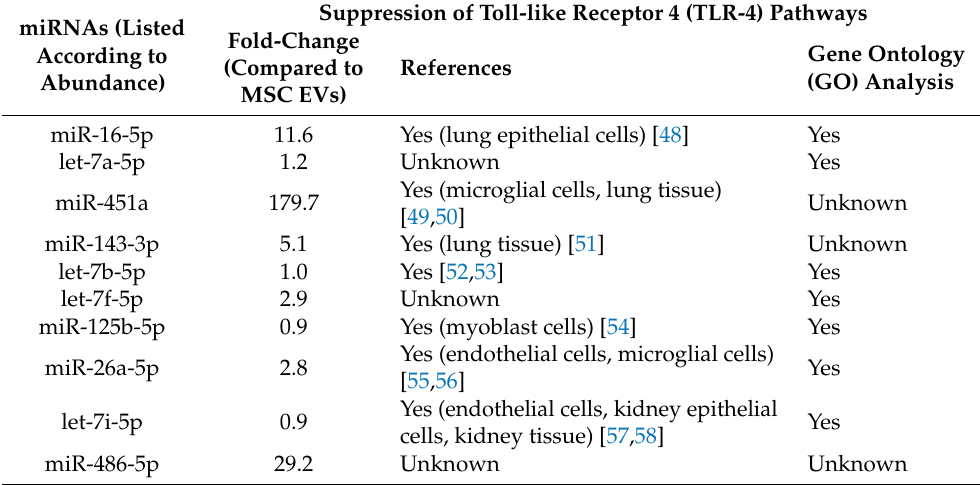
Table 2. Ten most abundant microRNAs (miRNAs/miRs) in adipose tissue biogenic nanoparticles (BiNPs) and fold-changes compared to donor-matched adipose-derived mesenchymal stromal cell (MSC) extracellular vesicles (EVs) based on trimmed mean of the M-values (TMM) normalization of next-generation sequencing